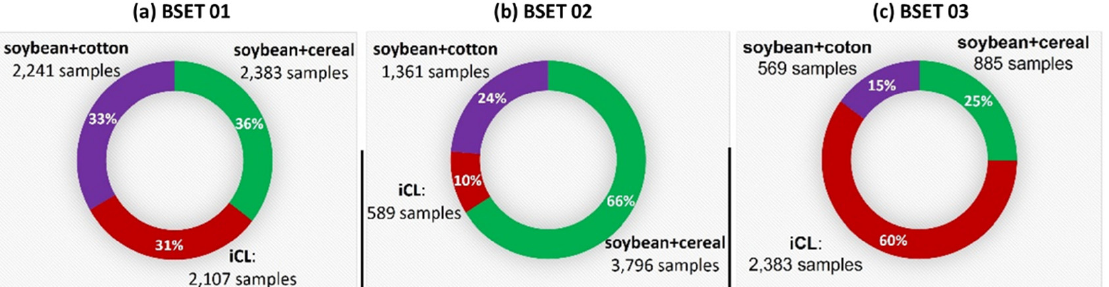
Figure 6. Composition of the training samples data-base (in % of the number of pixels), according to the three scenarios: ( a ) Bset01: Balanced number of samples per class; ( b ) Bset02: Unbalanced samples with a class distribution close to the one found in the field; ( c ) Bset03: Unbalanced samples with an over-representation of the iCL class.